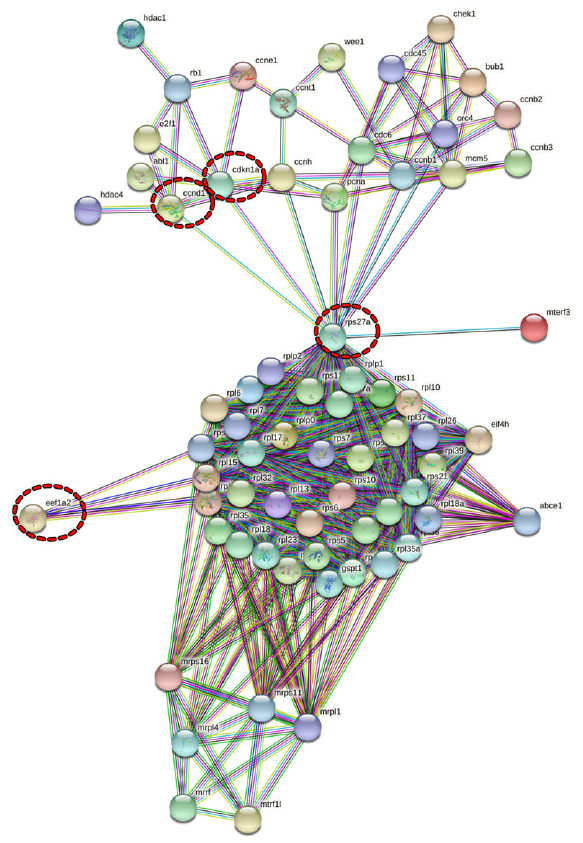
Figure 3. Molecular interaction network built on genes that enriched the cellular processes associated with proliferation and protein synthesis. The nodes represent the genes, and the edges represent the interactions between genes. The edge colors have different meanings: light blue: interactions from the curated databases; pink: interactions that were experimentally determined; green: neighborhood gene; red: gene fusions; dark blue: gene co-occurrence; lime: text mining; black: co-expression; and lilac: protein homology. In the upper region of the network are genes associated with the cell cycle, and in the lower portion are genes related to ribosomes. The dotted red circles highlight the genes selected for investigation: rps27a , ccnd1 , cdkn1a , and eef1a2 . The interaction score considered was